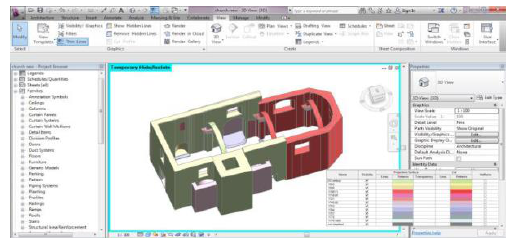
Figure 6. HBIM Model of the church St. Maria di Scaria, with stratigraphic information related to each singular object (Brumana et al.,